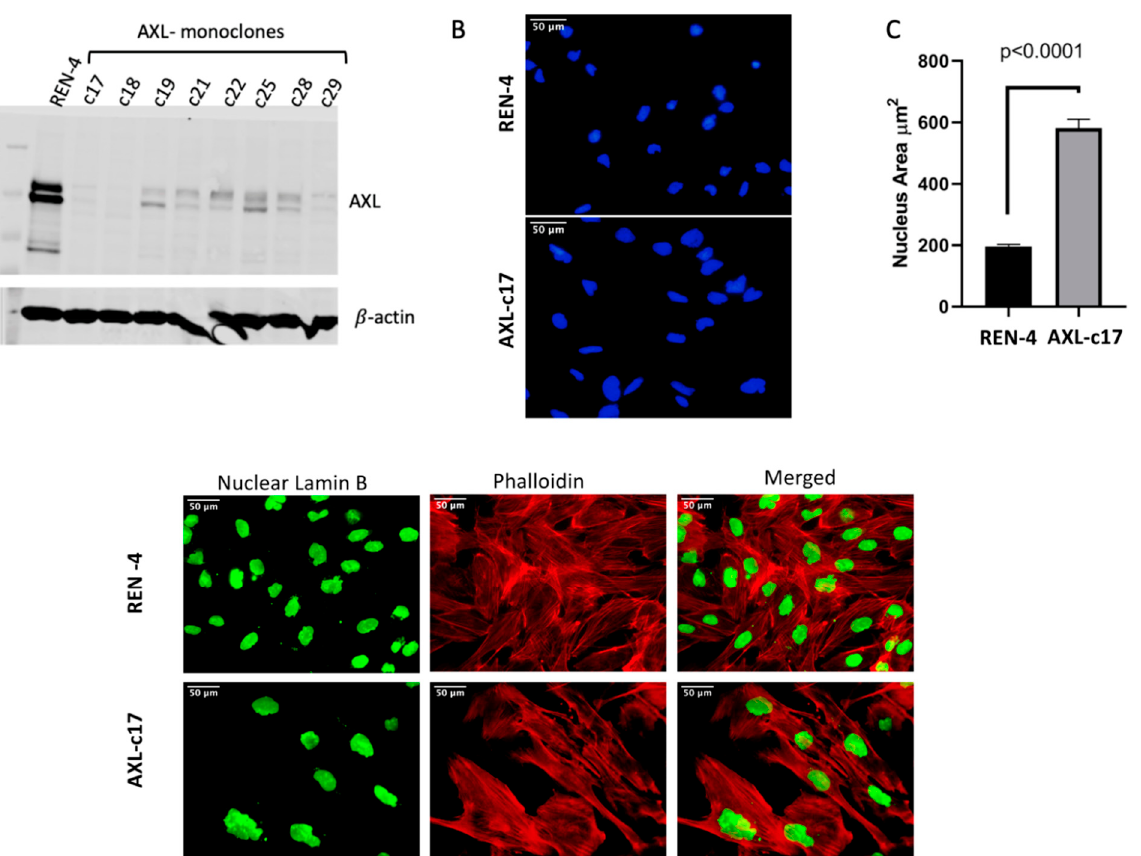
Figure 2. Expression levels of AXL in monoclones, REN-4 and AXL-c17, and changes in morphology and nucleus size. ( A ) 138 kDa AXL expression was detected in REN-4 negative control cells and AXL-monoclones except for the c17 and c18. β -actin served as a loading control. ( B ) Nucleus staining by DAPI (blue) in REN-4 (top) and AXL-c17 (bottom). ( C ) Nuclear areas were calculated by Image J program. Significantly larger nucleus sizes were observed in AXL-c17 ( p < 0.0001) ( D ) Phalloidin (red) which stains F-actin protein, highlights the differences in cell morphology and nuclear lamin B (green) shows the nucleus